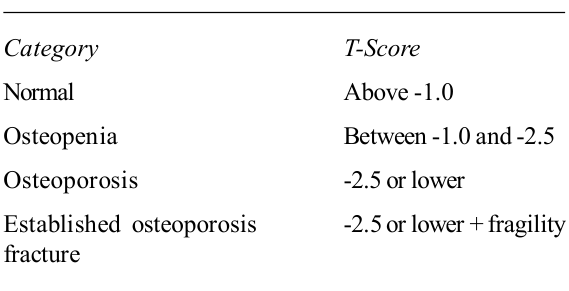
Table. T-score thresholds for categorization